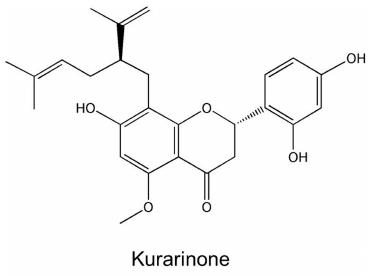
Figure 1. The chemical structure of kurarinone.